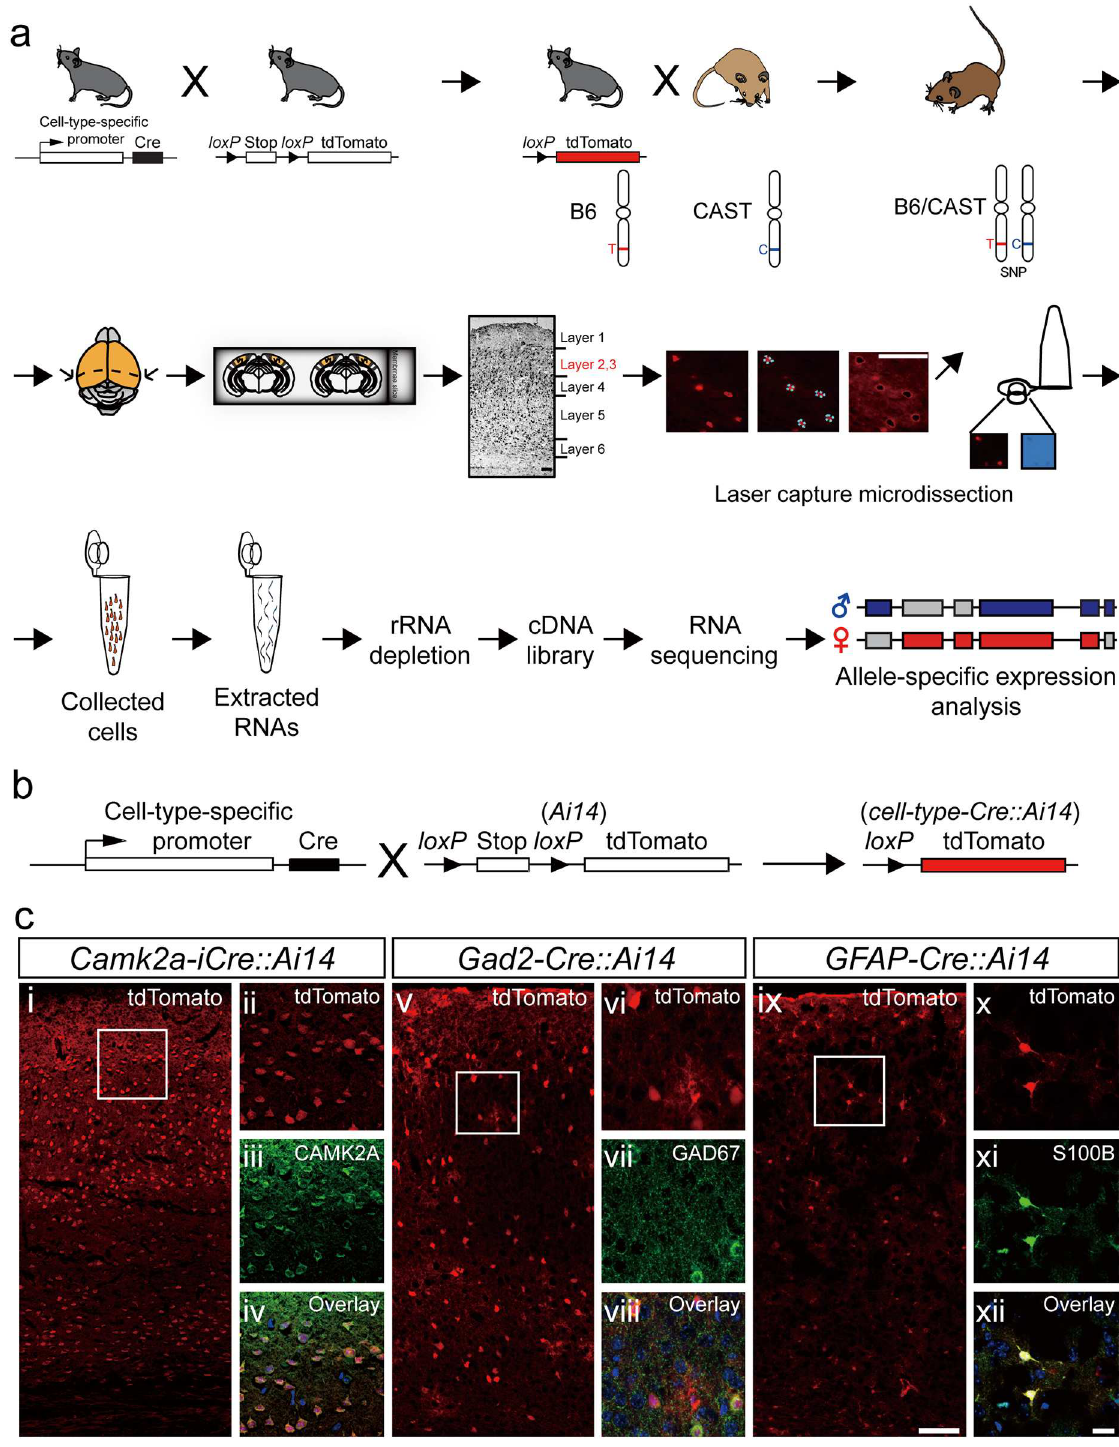
Fig 1. Process for detection and isolation of single cells from layer 2/3 of mouse visual cortex. ( a ) Schematic flowchart of the experimental design. Top : mating strategy to obtain B6/CAST mice. Middle : 7 μ m cryostat sections from P28 mice were cut and single cells were identifiedfor laser capture microdissection (LCM) as excitatory neurons, inhibitoryneurons or astrocytes in layer 2/3 of the visual cortex. Scale bar, 50 μ m. Bottom : LCM single cells were collectedand RNA was extracted. A cDNA library, was generatedfor each cell type followedby RNA-Seq, and allele-specific expression in the cellular transcriptome was analyzed.